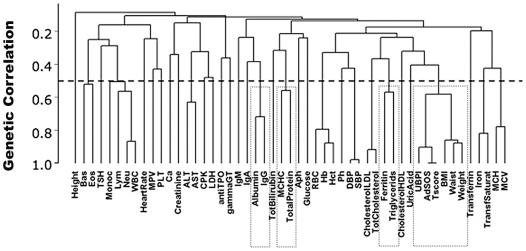
Clusters of genetic correlation.The 52 traits were classified into clusters inferred from genetic correlations between any two traits using the hclust function of R (http://www.r-project.org/). Genetic correlations are indicated on the Y-axis, with the highest correlations toward the bottom. Twelve values exceeded 50% correlation (table S7). Dotted squares highlight not expected genetic correlations. Abbreviations are as in table 1 and 2.